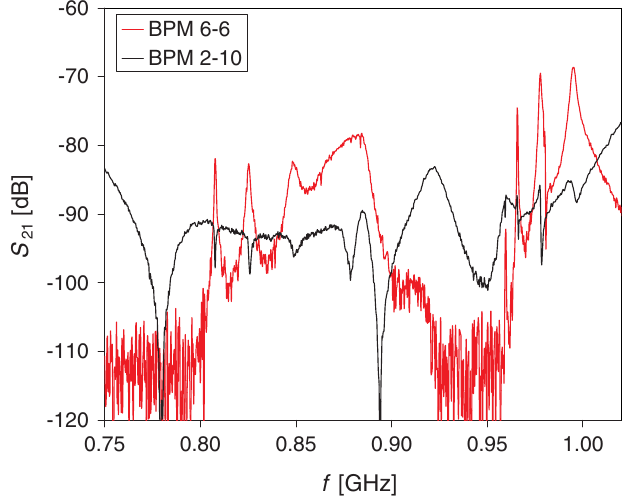
FIG. 3. HOM spectra of the ECX cavity at room temperature. The red curve shows the transmission through the cavity (BPM 6-6), while the black curve shows transmission between two probes in the upstream tube (BPM